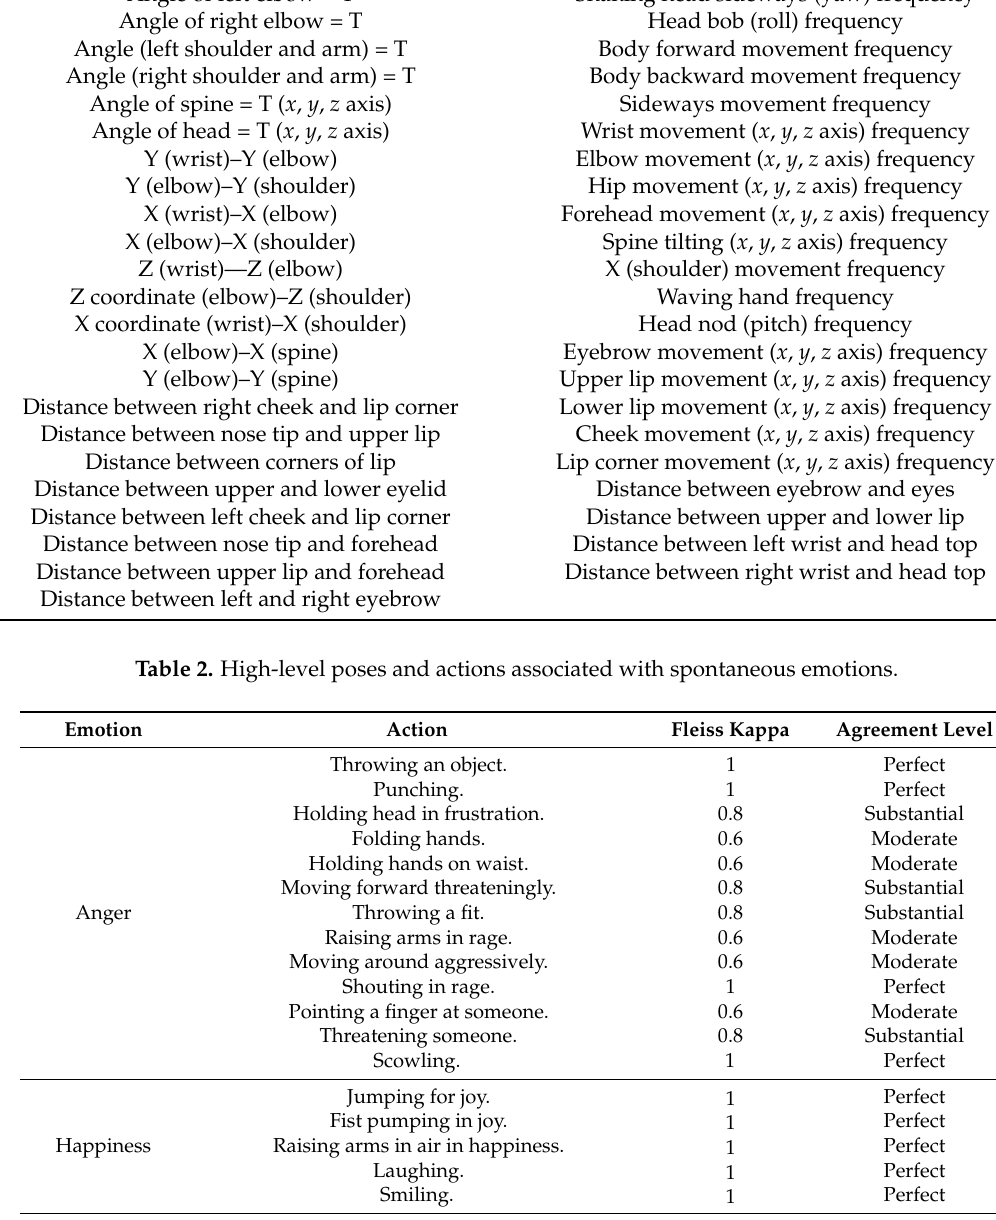
Table 1. Low-level descriptors for behavioral pattern-based feature extraction. Angle-, Frequency-, and Distance-Based List of Features Angle of left elbow = T Shaking head sideways (yaw) frequency Angle of right elbow = T Head bob (roll) frequency Angle (left shoulder and arm) = T Body forward movement frequency Angle (right shoulder and arm) = T Body backward movement frequency Angle of spine = T ( x , y , z axis)